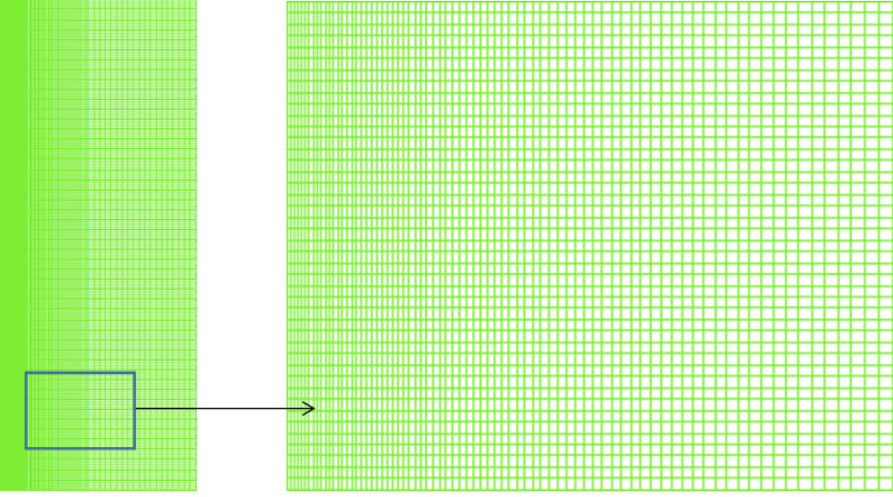
Figure 2. Global grid and local grid of 2D model.